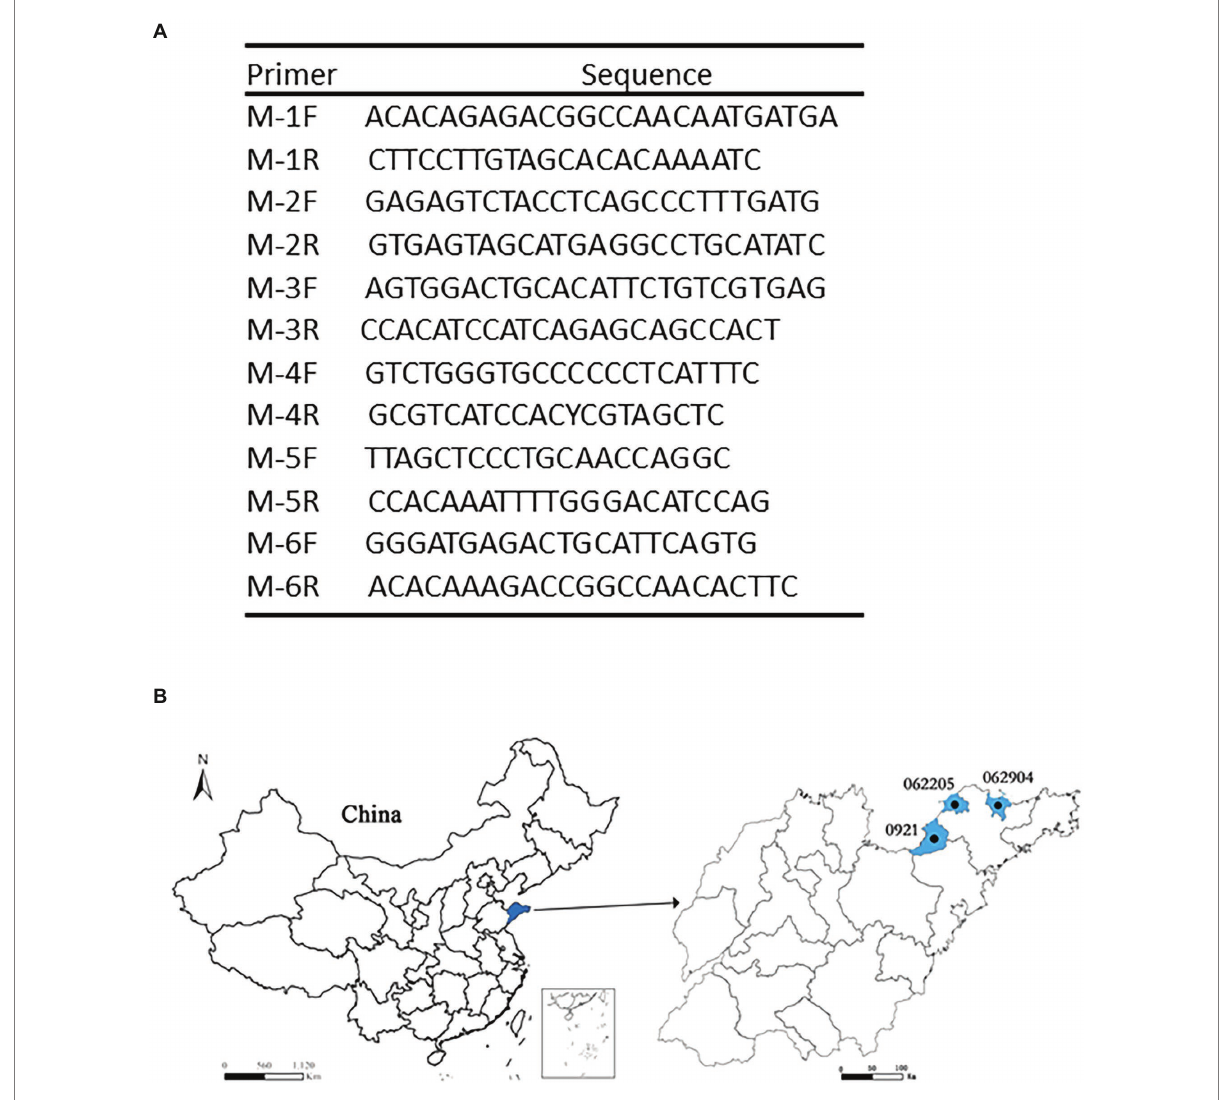
FIGURE 1 The geography distribution of SFTSV studied. (A) The six primers pairs were showed. From M-1F, M-1R to M-6F, M-6R. (B) The geography distribution of SFTSV. The blue part showed the Jiaodong area in Shandong province on the left, and the blue on the right is the distribution of different clades (0921, 062205, and